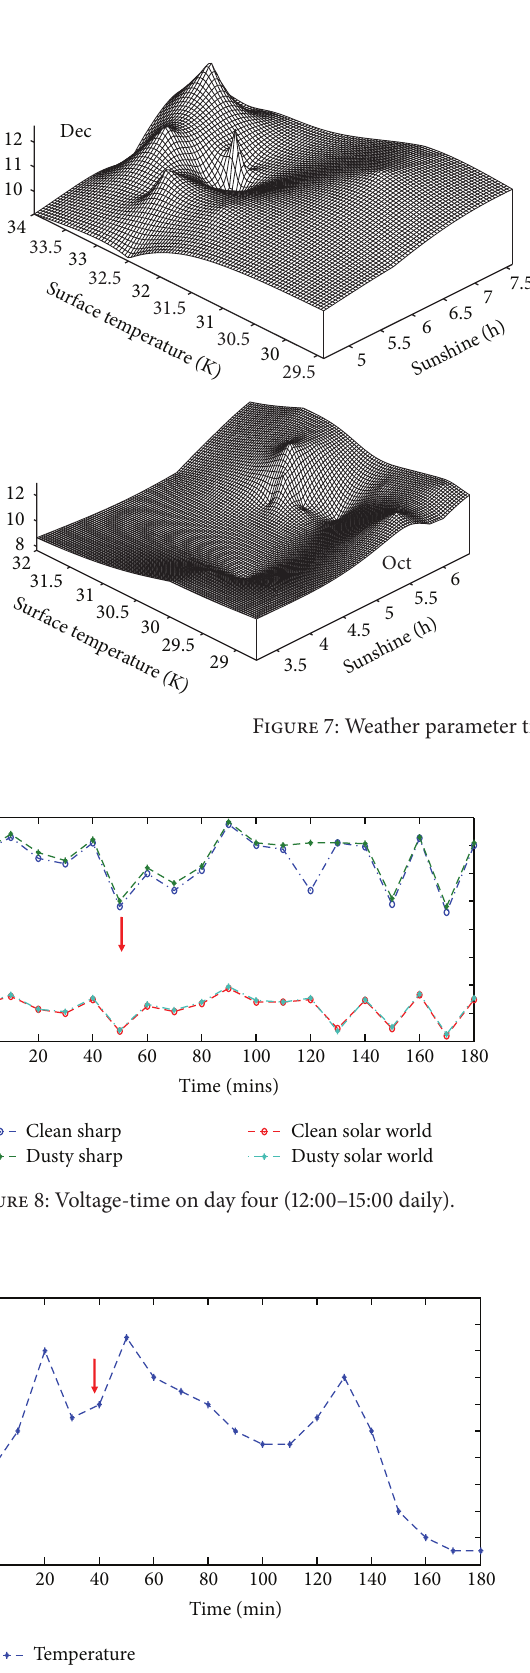
Figure 9: Temperature-time on day four (12:00–15:00 daily).